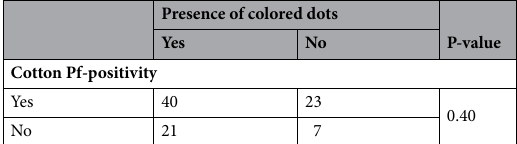
Presence of colored